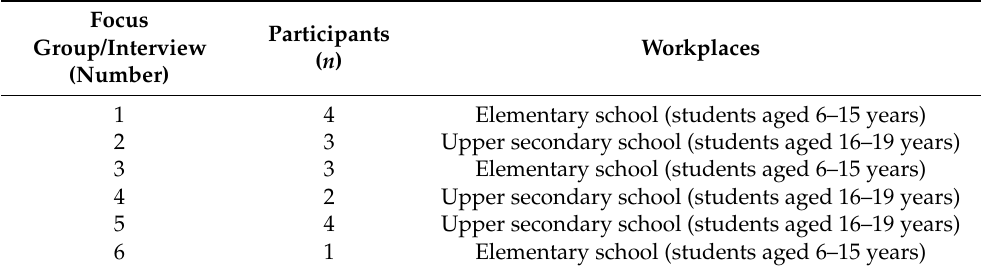
Table 1. Focus groups and individual interviews, number of participants, and workplaces.